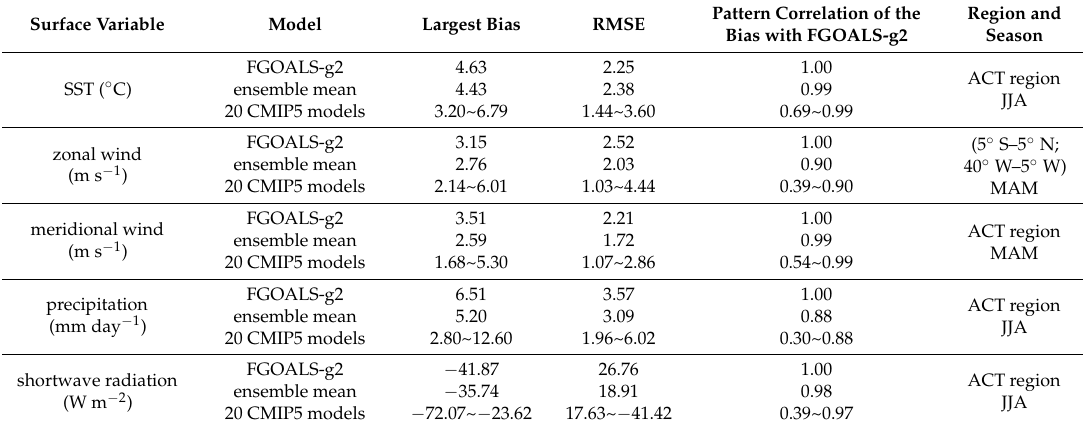
Table 2. Detailed information of SSTs and atmospheric forcings for FGOALS-g2, 20 CMIP5 models, and their ensemble means.